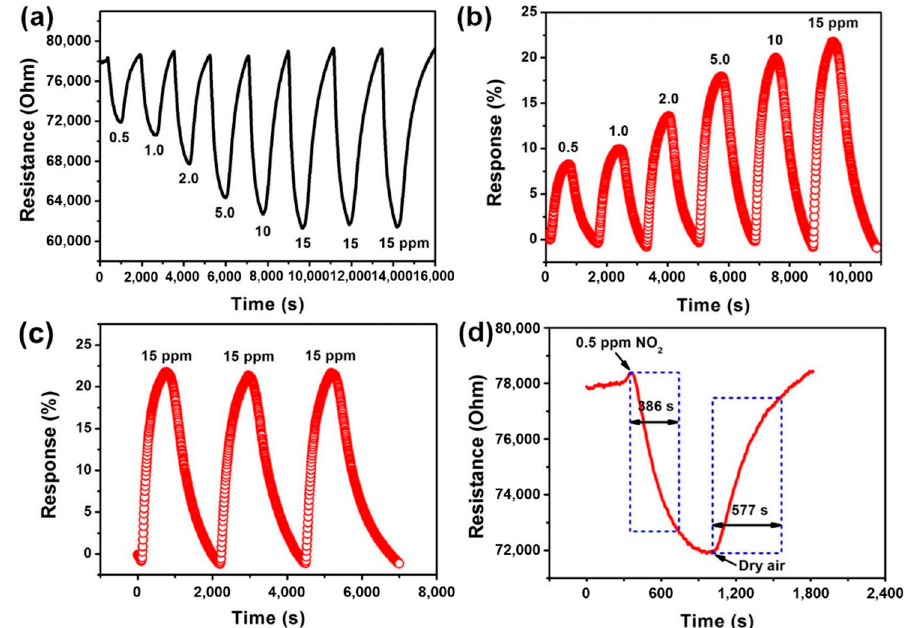
Figure 5. Response of rGO film (spin coating) from 0.5–15 ppm NO 2 ( a ) Real-time sensing resistance curve, ( b ) Real-time sensing response curve from 0.5–15 ppm, indicating response of 8.3%, 10.1%, 13.6%, 17.9%, 21.8% and 22.5%, respectively, ( c ) Reproductivity curve of rGO film prepared by spin-coated method, ( d ) Real-time resistance change curve of rGO film prepared by spin coating in 0.5 ppm NO 2 .